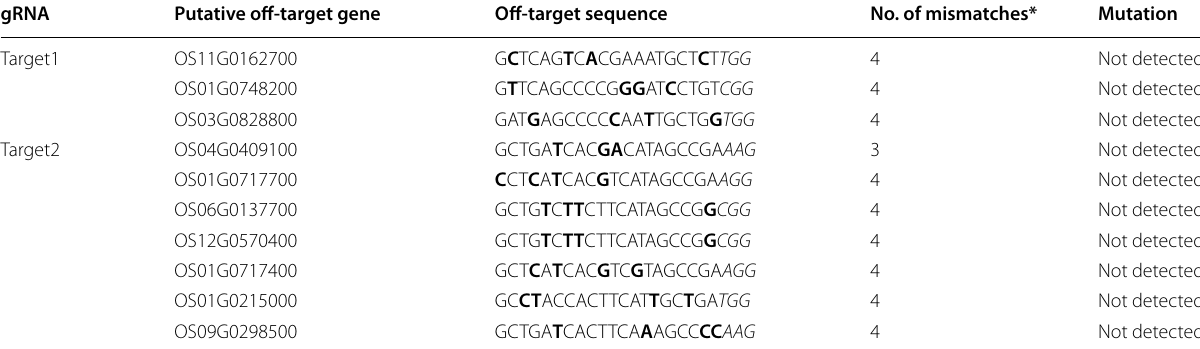
* Mismatching bases are in bold. Nucleotides in italics represent PAM sequences